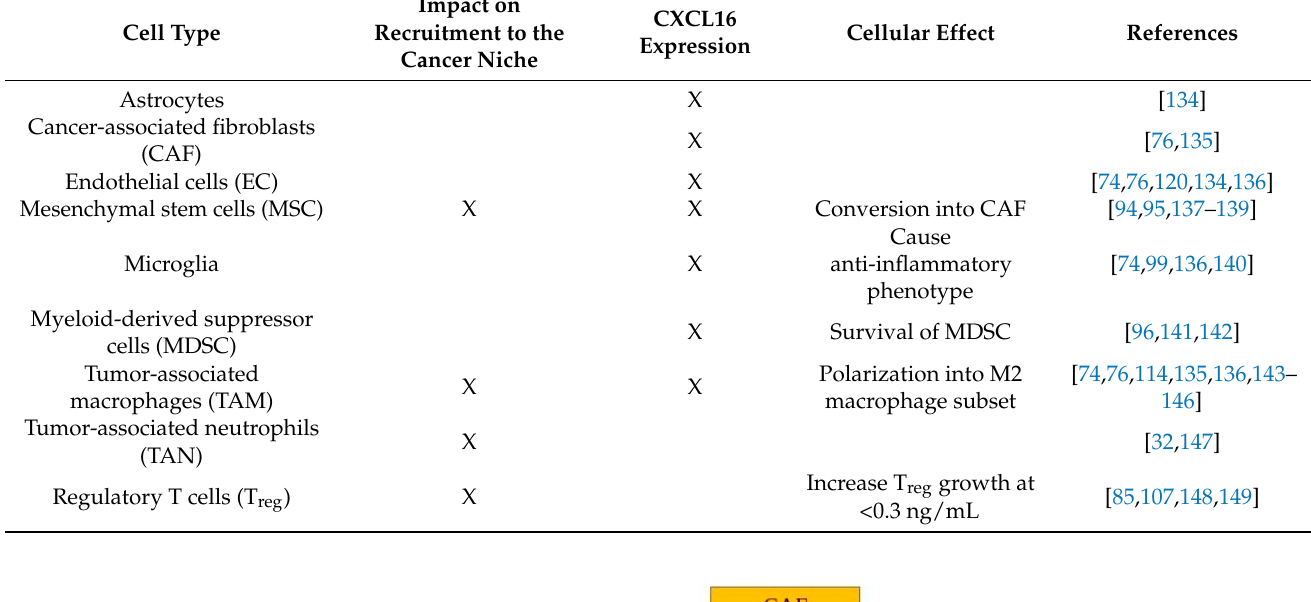
Table 2. The importance of tumor-associated cells in the functioning of the CXCL16 → CXCR6 axis.